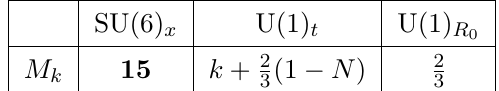
Figure 1 . Quiver diagram of the original gauge theory. The round node denotes the USp(2 N ) gauge symmetry, while the square node the SU(6) flavor symmetry. The line connecting them represents the chiral in the bifundamental representation of the two groups, while the arc denotes the chiral in the antisymmetric representation of the gauge group. The dash over the arc denotes the tower of β singlets. i